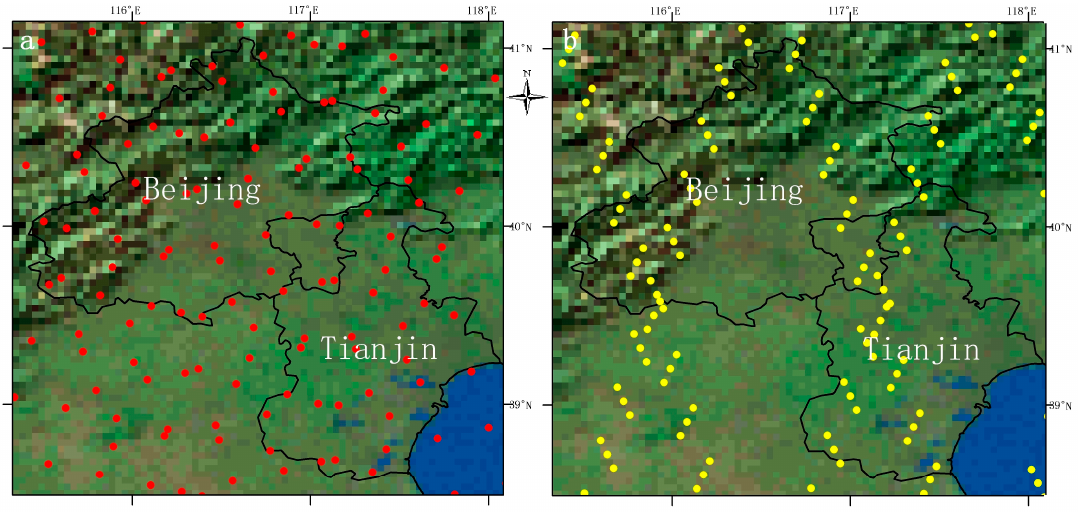
Figure 5. ( a , b ) Coverage of the CO 2 -IDPA for two months using different orbit altitudes. The symbols are as defined for Figure 4.